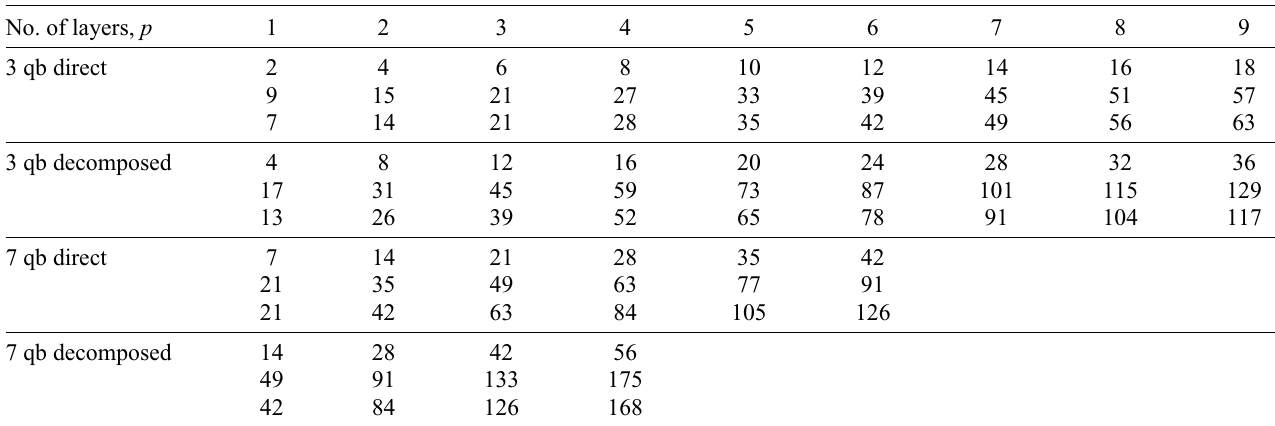
TABLE III. Number of two-qubit gates (first row), single-qubit microwave-driven gates (second row), and single-qubit virtual gates (third row) in the implemented QAOA